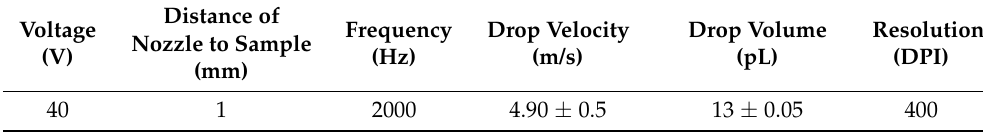
Table 1. Inkjet printing